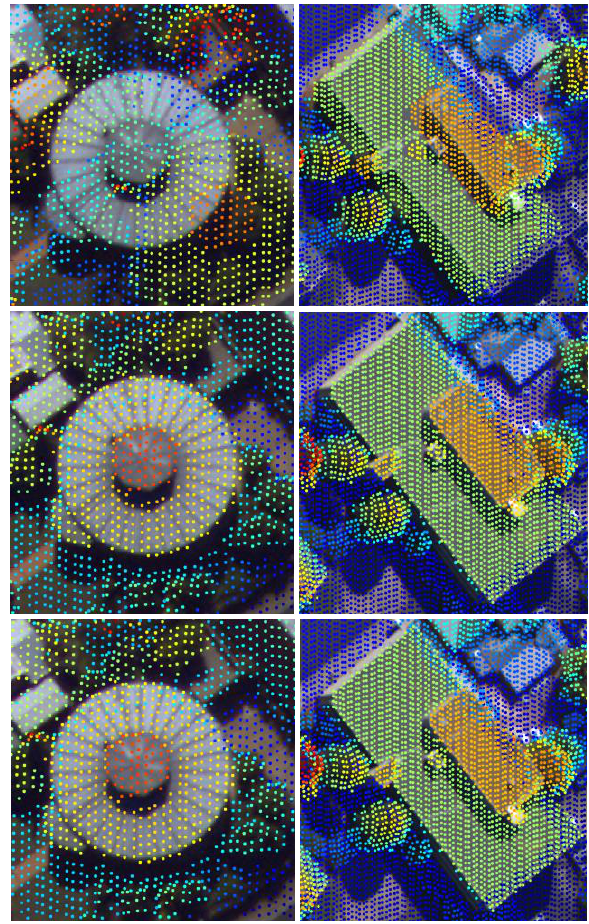
Figure 8. Overlay of back-projected LiDAR point cloud on to the aerial image before (top) and after registration using the feature-based method (middle) and intensity-based method (bottom) The results of registering the optical image to LiDAR data, shown in Figure 8, indicate a precise match between corresponding features. Although both registration methods provided good results, the intensity-based method achieved a more accurate registration due to both the use of well- distributed templates and the sub-pixel accuracy achieved in the template matching